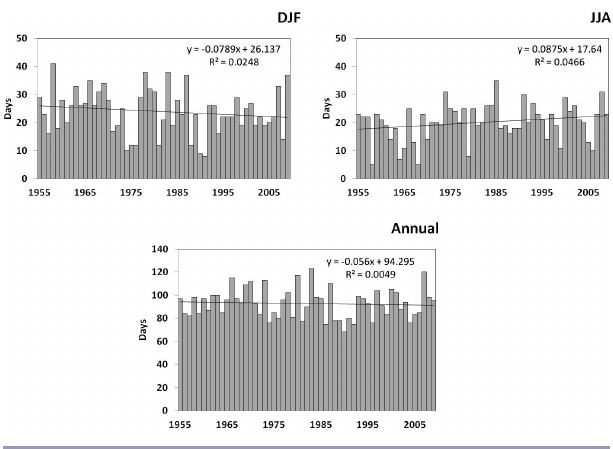
Fig. 3 . Rainfall variability 1955-2009 compared with 1981-2010 climatology (normal values).